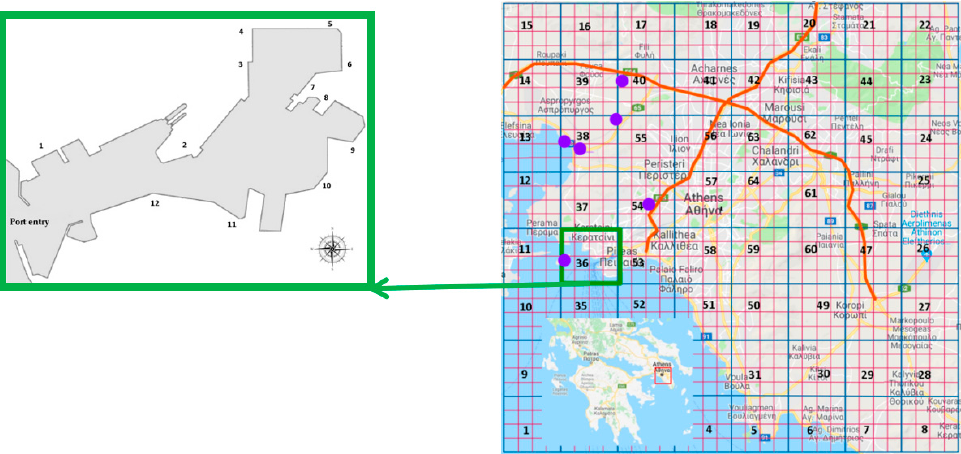
Figure 2. The study area of the GAA, Greece (Map modified from Google Maps). Subdomain grid depicted in blue, grid cells in red, highways as orange lines, industrial facilities as purple dots, and the area of Piraeus port (port layout from the work in [30]) outlined in green.